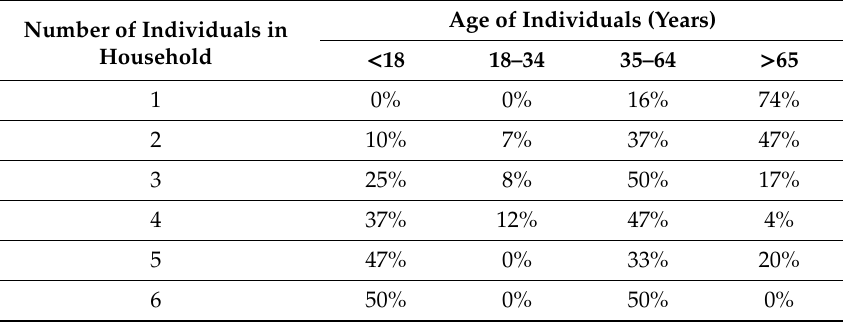
Table 2. Composition by the age of monitored households by the number of